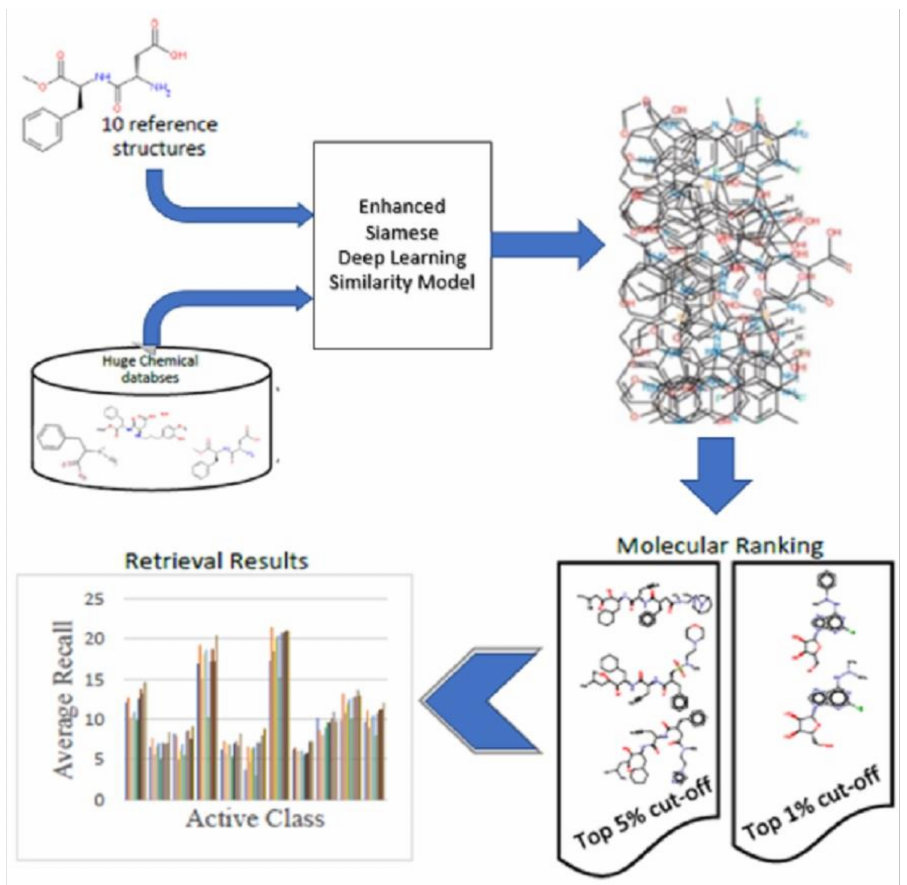
Figure 6. The general steps of the experimental design of this study.